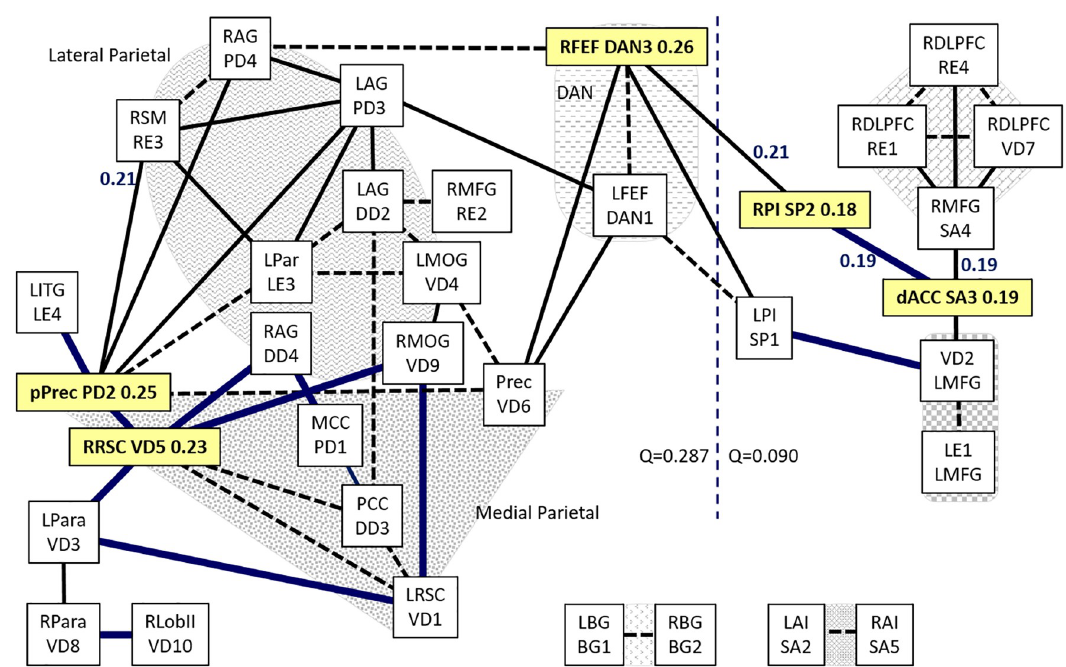
Fig 2. 0-back connectivity in SC. All edges with d > 1.6 and FDR < 0.01 were plotted as a ball and spring diagram. The dotted line separated task and default modules based on the Louvain method [79] weighted by Fisher’s z-transformed Pearson correlation coefficients. Edges that were significant exclusively in SC were depicted by thick blue lines. Dashed black lines indicated edges shared by all 3 groups. Thin black lines were shared by pairs of groups. Yellow colored nodes had betweenness centrality > 0.15 or were of special functional significance in SC. Edge betweenness centrality > 0.15 was indicated. Grey shaded areas indicated medial parietal, lateral parietal, DAN, RDLPFC, left ventrolateral prefrontal cortex, basal ganglia and anterior insulae